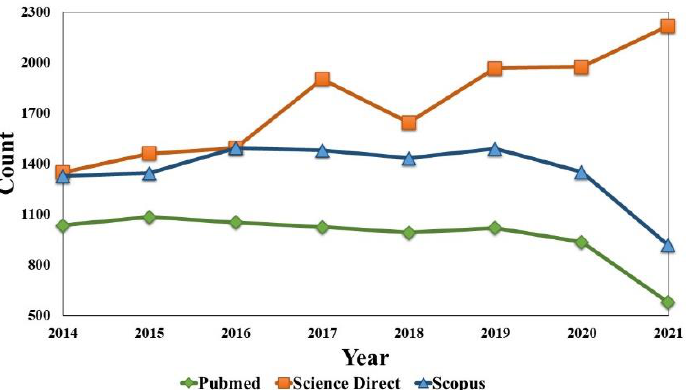
Figure 1. The number of publications about lactide in the last few years in common database re- search platforms for the search item “lactide”.